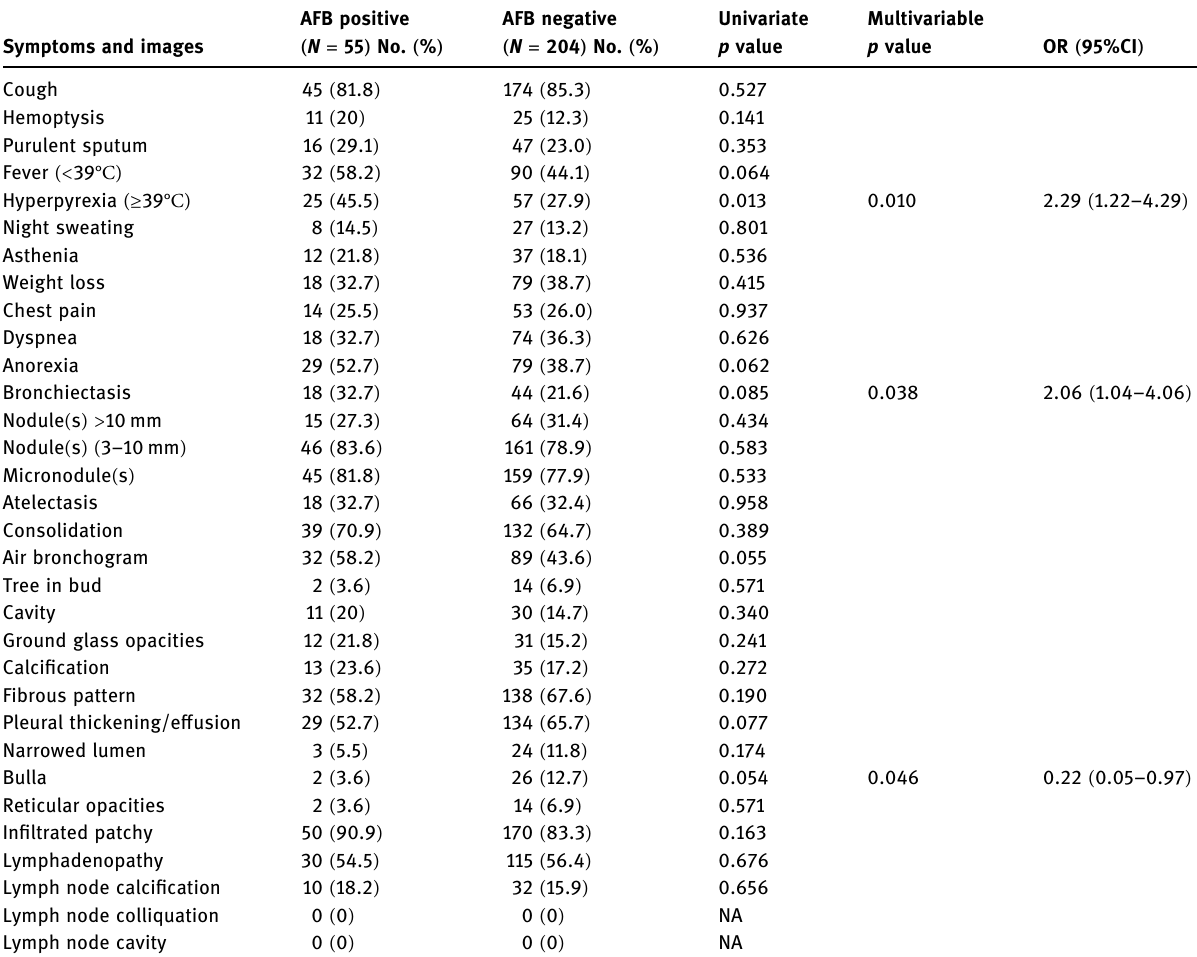
Table 2: The symptoms and radiological fi ndings in di ff erent AFB status AFB positive AFB negative Univariate Multivariable Symptoms and